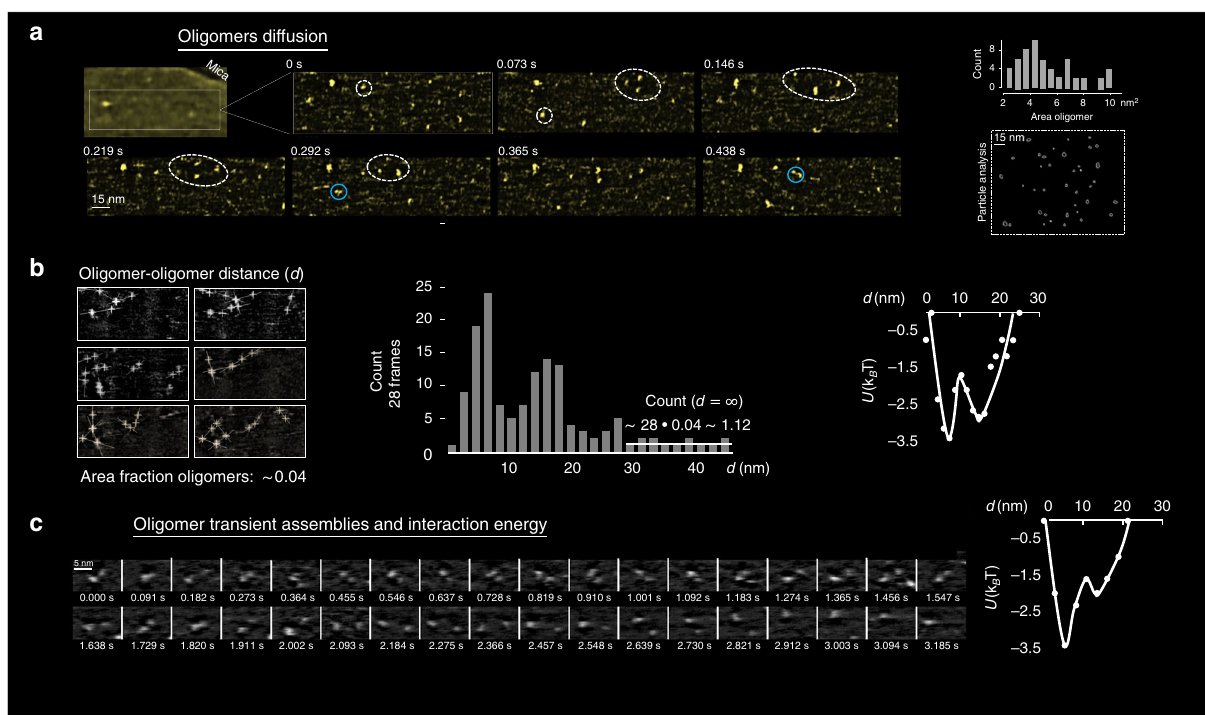
Fig. 3 Sub-MIC Dap on POPG at 37 °C. First minutes. Initial stages. a Oligomers of Dap in diffusion on a membrane (slashed circles). The upper left image shows the membrane and the underlying mica substrate (colour scale: 4 nm). The rest of the images are close-ups on top of the membrane (colour scale: 2 nm): The oligomers formed temporary ensembles (slashed ellipses), but they did not form permanent clusters. Movie details: frame rate 74 ms; full image size 180 nm × 60 nm; full-frame size 256 × 80 pixels. a , right, The particle analysis (right bottom, one of the frames analysed; right top, histogram) shows a spread in the area of the oligomers from 2 to 10 nm 2 , a peak value of 4.3 nm 2 , and a mean and standard deviation of 5.4 ± 3.2 nm 2 ; which corresponds to a stoichiometric variability maximal of 1 to 6 monomers, and mean and standard deviation of 3.6 ± 2.1 monomers. The oligomers experience mutual attraction at short distances. b , left, Oligomer-oligomer energy pro fi le obtained from the spatial distribution of oligomer-oligomer distances. The area fraction of the oligomers on the membrane is of ~0.04. b , centre, Minima are found at distances between oligomers of ~7 and ~16 nm. The count at far distance ( count ∞ ) can be calculated to be ~1.12 (area fraction occupied by the oligomers (0.04; ~4% of the total membrane area) multiplied by the number of frames counted ( n = 28), horizontal white line at d > 30 nm) in agreement with the count at d > 30 nm. b , right, Equilibrium Boltzmann distribution energy pro fi le derived from U( d ) = − k b Tln[ count ( d )/ count ∞ ]; the depthless of the energy wells is estimated to be of − 3.4 k B T at d = 7 nm and − 2.8 k B T at d = 16 nm. c These 32 frames (2.821 s) show a pair of oligomers in interaction. c , right, From the count of d , the energy pro fi le features one global ( d = 7 nm) and one local ( d = 16 nm) minima. Because the oligomer-oligomer interaction is ergodic and, as expected, the interaction pro fi le in space is similar to interaction pro fi le in time. This allows to derive the energy values of the interaction pro fi le in time from the in space